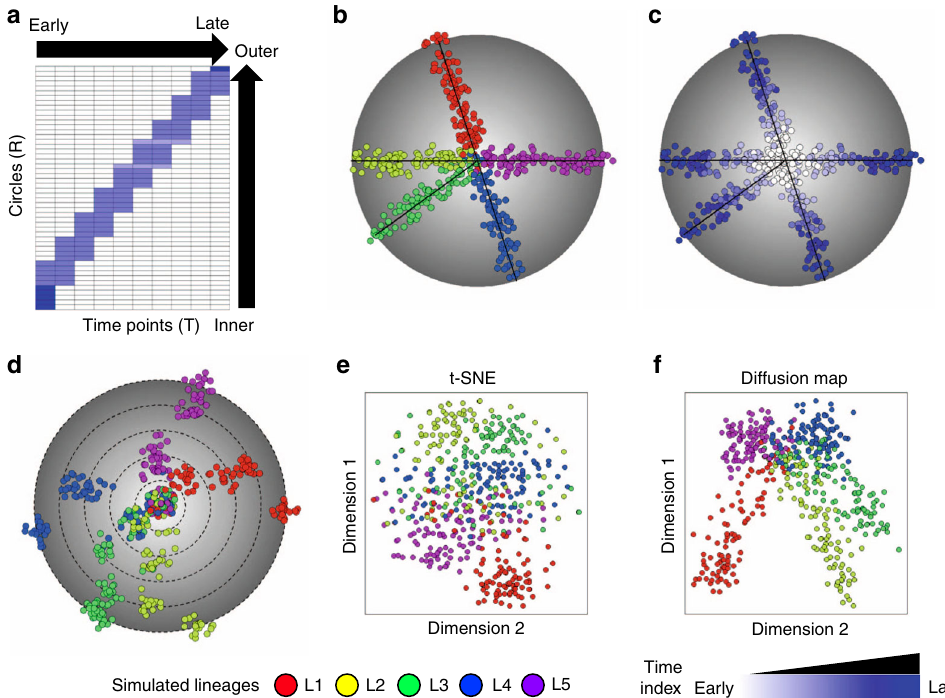
Fig. 2 TCM has improved performance for the detection of subpopulations of cells in simulation study . a The heatmap shows the sampling probabilities for the sequential differentiation models. In the sequential cell sampling, the sampling time is positively correlated to the developmental speed. b-c The simulated temporal scRNA-seq datasets with fi ve lineages under sequential differentiation models ( N = 2000 genes and M = 500 cells, with an exponential decay model for the dropout noise), with the color indicating ( b ) the cell lineages or ( c ) time index. d TCM was able to successfully reveal the lineage trajectories for the sequential differentiation models. e-f The visualization of simulated temporal scRNA-seq datasets under three differentiation models by ( e ) t-SNE and ( f ) diffusion